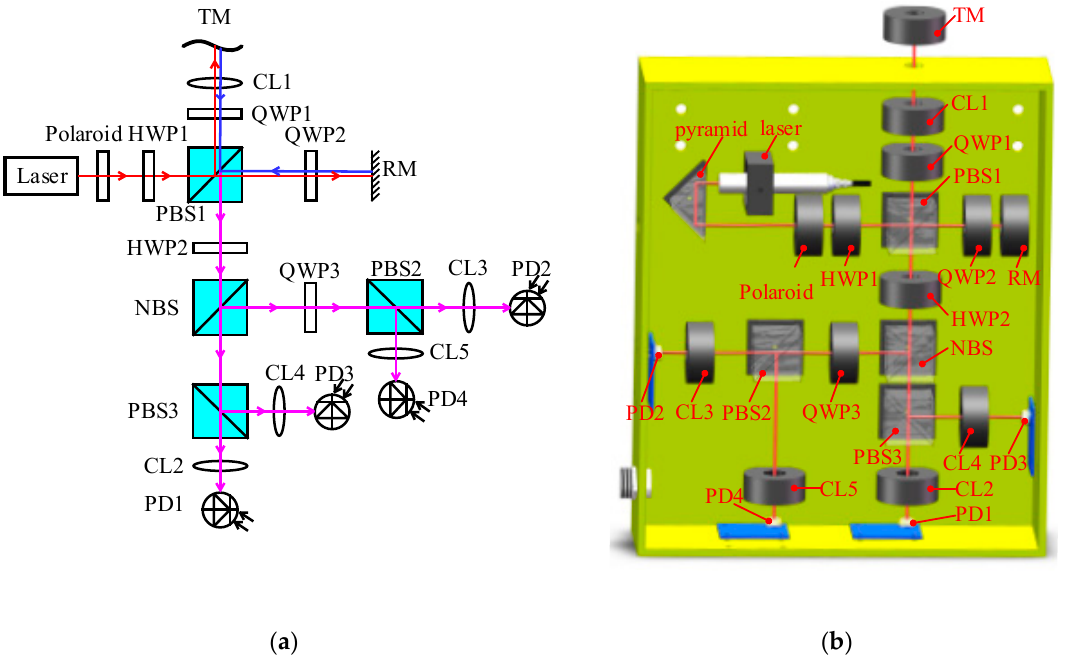
Figure 3. Scheme and design of the proposed nano-resolution laser interferometry sensor: ( a ) scheme of nano-resolutionlaserinterferometrysensorand( b )thedesignofthenano-resolutionlaserinterferometry sensor: HWP1, first half-wave plate; HWP2, second half-wave plate; PBS1, first polarizing beam splitter; PBS2, second polarizing beam splitter; PBS3, third polarizing beam splitter; RM, reference mirror; TM, target mirror; QWP1, first quarter-wave plate; QWP2, second quarter-wave plate; QWP3, third quarter-wave plate; NBS, non-polarizing beam splitter; PD, photodiode; CL, convex lenses.